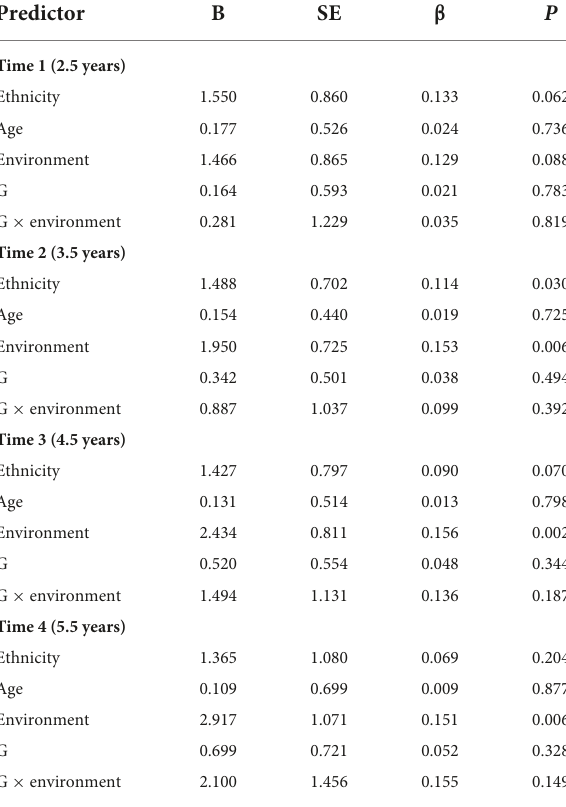
TABLE 5 Main and gene–environment interaction effects of rs2267735 on the course of posttraumatic stress disorder symptoms at 2.5, 3.5, 4.5, and 5.5 years after the earthquake (in girls).